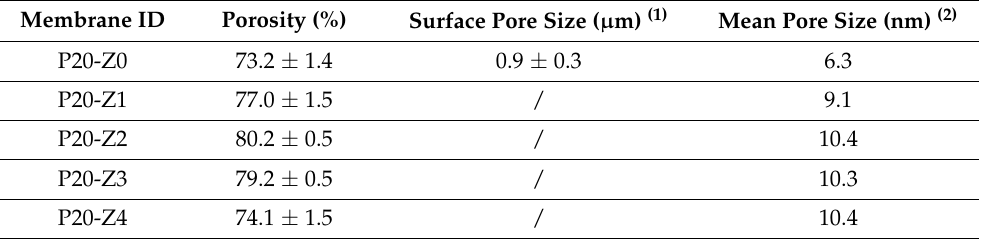
Table 1. Porosity and pore size of the virgin and modified PSf membranes. (1) Evaluated when possible from SEM, (2) Evaluated from Equation